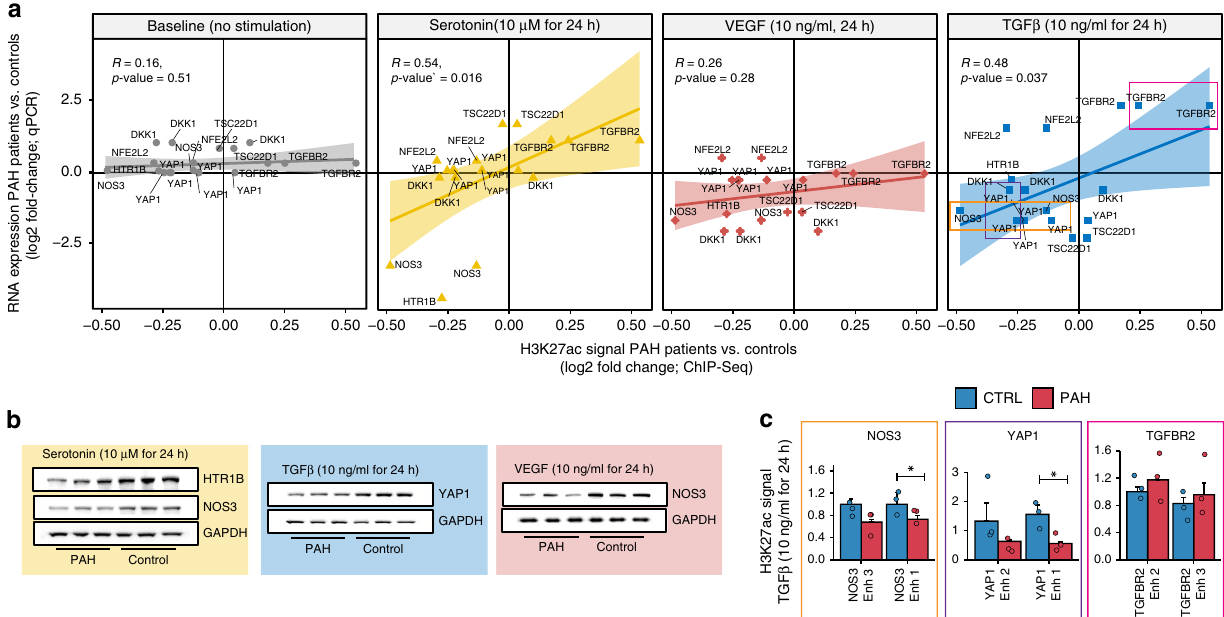
Fig. 6 Experimental growth factor stimulations in PAECs con fi rms priming. a Log2 fold-change of the gene expression (as measured by RT-qPCR) and the H3K27ac signal (as measured by ChIP-Seq) of the regulatory element(s) linked to the gene are shown as scatter plot. Each point is a regulatory element-gene pair. The fold-changes are calculated between PAH patients and controls in steady state for H3K27ac and after a stimulation with endothelial-speci fi c growth factors (serotonin — yellow triangles, vascular endothelial growth factor (VEGF) — red crosses, and transforming growth factor β (TGF β ) — blue squares) for the RNA. Pearson correlation coef fi cients (R) and associated p -values are given in the plots. (qPCR experiments: n = 4 patients, four controls). b Western blot analyses are shown for a selection of genes that showed a differential response to any of the stimulations on the RNA level. GAPDH levels are shown as a reference. Source data are provided in Source Data File. c ChIP-qPCR analysis for enhancers predicted to prime response in PAH patients. H3K27ac signal at selected enhancers (Enh; orange, brown and pink box for NOS3, YAP1, and TGFBR2), was measured after TGF β stimulation in patient and controls. All of the enhancers showed a trend in the predicted direction and some of them statistically signi fi cant ( n = 3 patients, three controls). Error bars indicate standard deviation across three